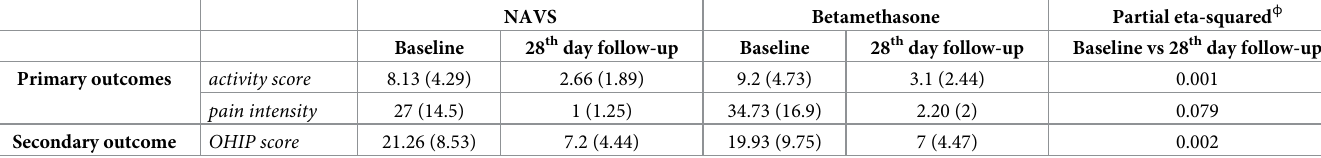
ф Effect size for treatment differences between NAVS and Betamethasone group.